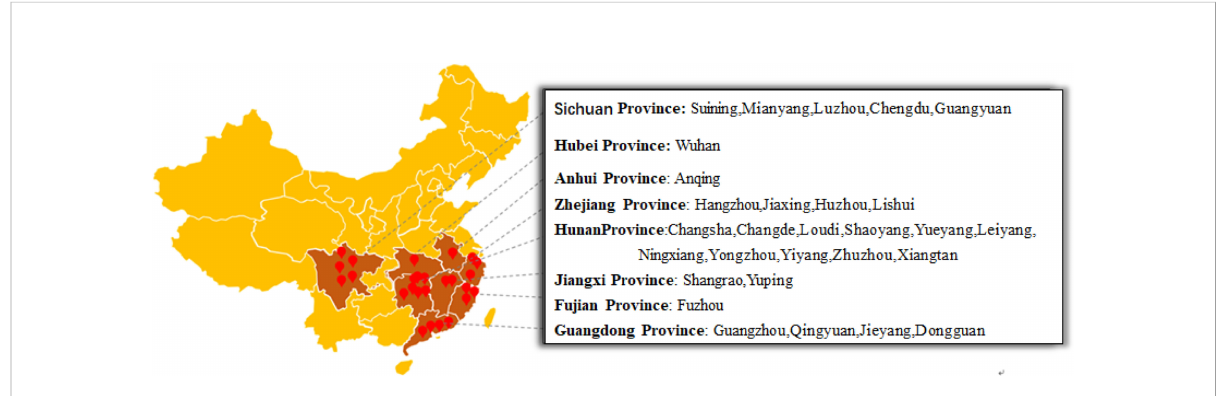
FIGURE 1 Sample collections of Phomopsis blight of eggplant and distribution in